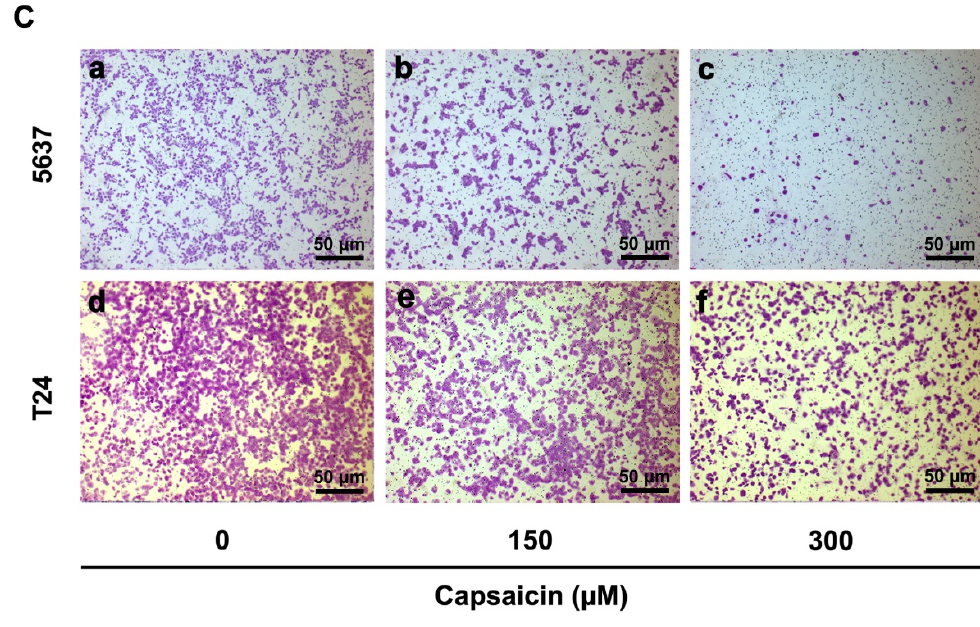
Figure 1. ( C ) Transwell migration assay for CAP treated 5637 ( a – c ) and T24 cells ( d – f ) at 0, 150 and 300 µM for 48 h. The scale bar for ( a – f ) is 50 µm. The error does not change the conclusion or interpretation of our results. Nevertheless, we consider it necessary to correct the misplaced